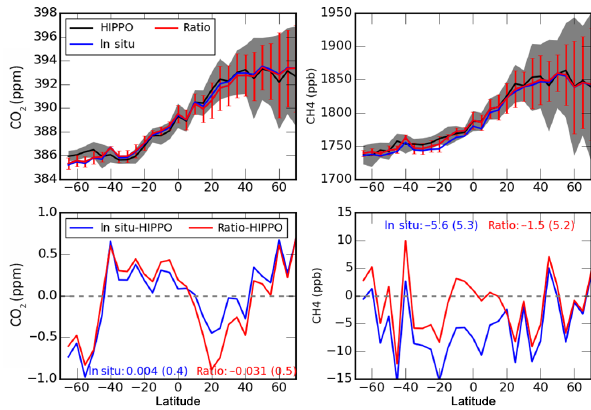
Figure A2. (Top) HIPPO-3 (Wofsy et al., 2011), May 2010, and a posteriori model partial columns of (left) CO 2 and (right) CH 4 as a function of latitude over the Pacific Ocean, and (bottom) the differ- ences between the observations and the in situ and ratio inversions. The mean biases (standard deviations) between the model and data are shown in the inset of the lower panels. Data and model values are binned into 5 ◦ mass-weighted latitude